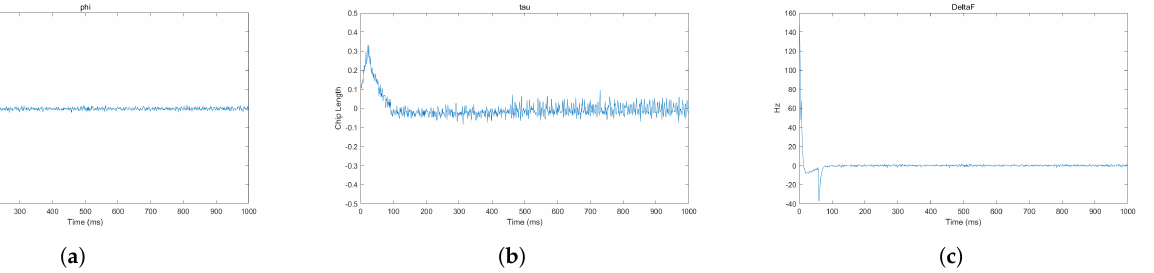
Figure 15. Tracking performance on key parameters measurement. ( a ) Tracking on Phase Parameter. ( b ) Tracking on Code Delay Parameter. ( c ) Tracking on Frequency